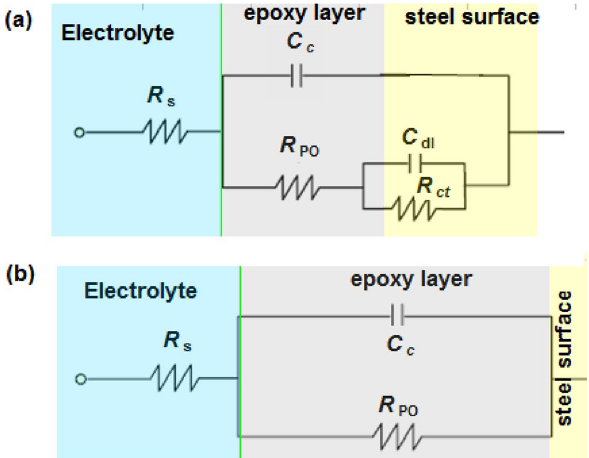
Figure 3. equivalent electric circuits for ( a ) neat epoxy, P–Ni/epoxy nanocomposite and P–Zn/epoxy nanocomposite; ( b ) P–Mg/epoxy composite.